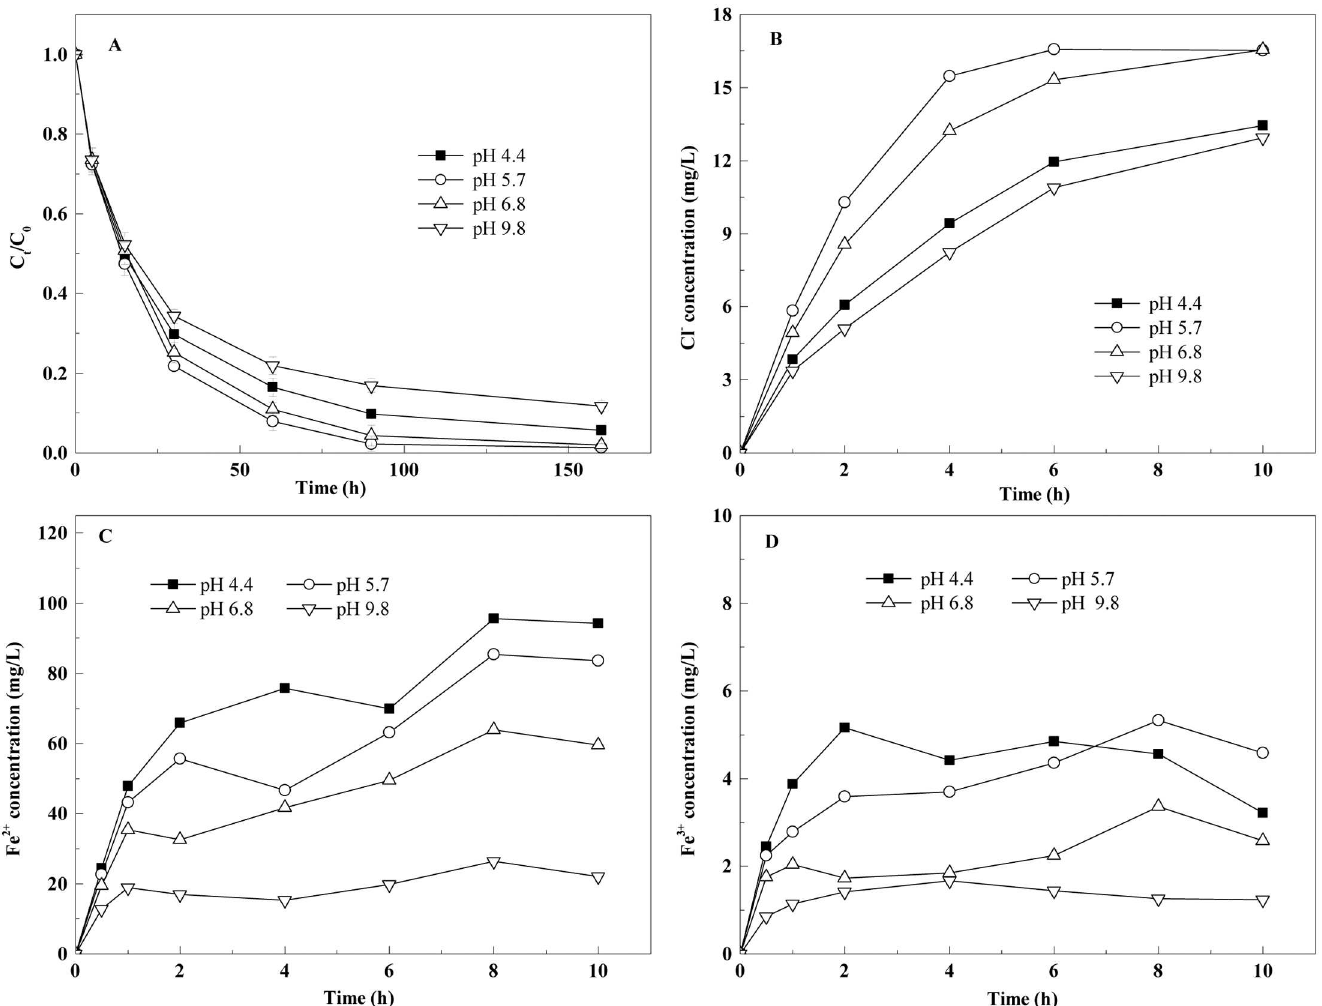
Fig 3. Removal of TCE by the BC-nZVI with different initial pH values. A , Effect of the initial solution pH on the removalof TCE by the BC-nZVI; B , Cl − concentrations in solutionswith different initial pH values; C , Fe 2+ concentrations in solutionswith different initial pH values; D , Fe 3+ concentrations in solutionswith different initial pH